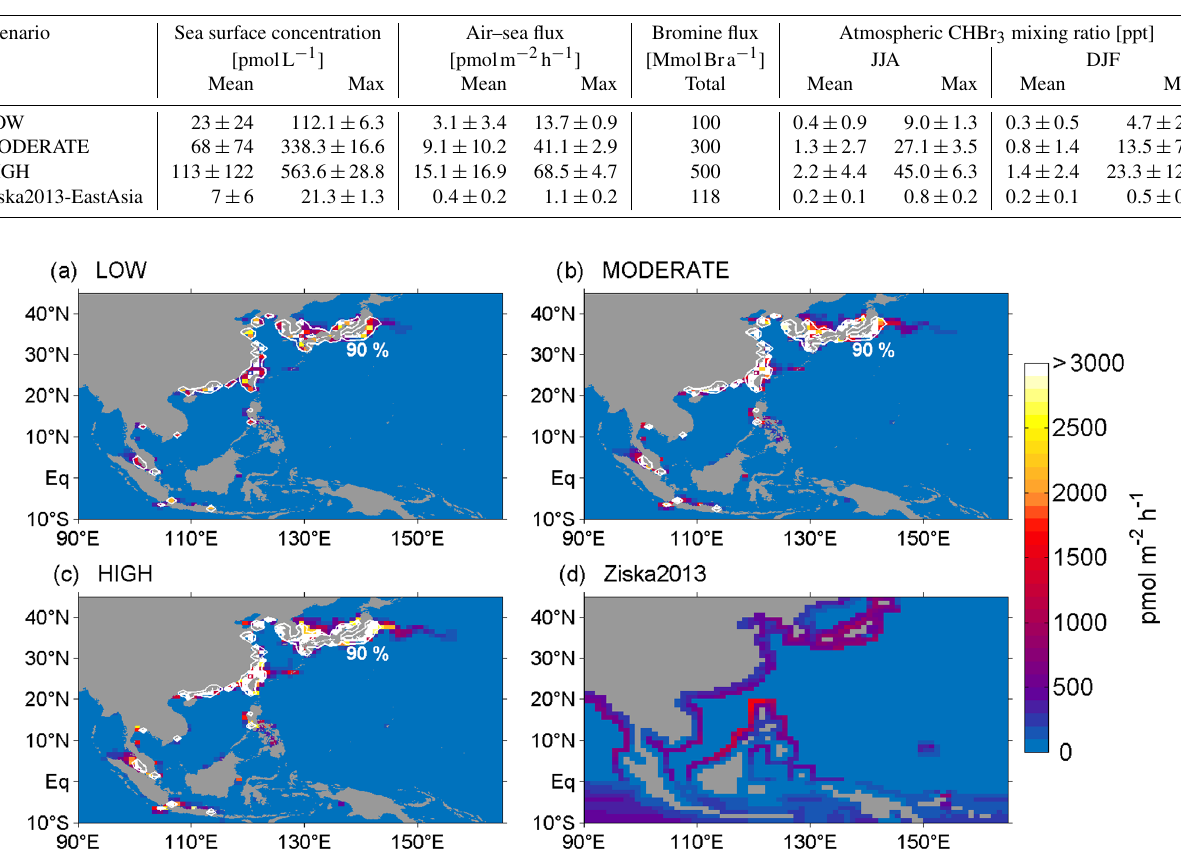
Figure 5. Annual mean air–sea flux of bromoform in pmolm − 2 h − 1 for the three scenarios (a) LOW, (b) MODERATE, and (c) HIGH, as well as (d) the air–sea flux calculated from updated ocean and atmospheric maps following Ziska2013. The white contour line in panels (a) – (c) shows the patches where 90% of the largest emissions are